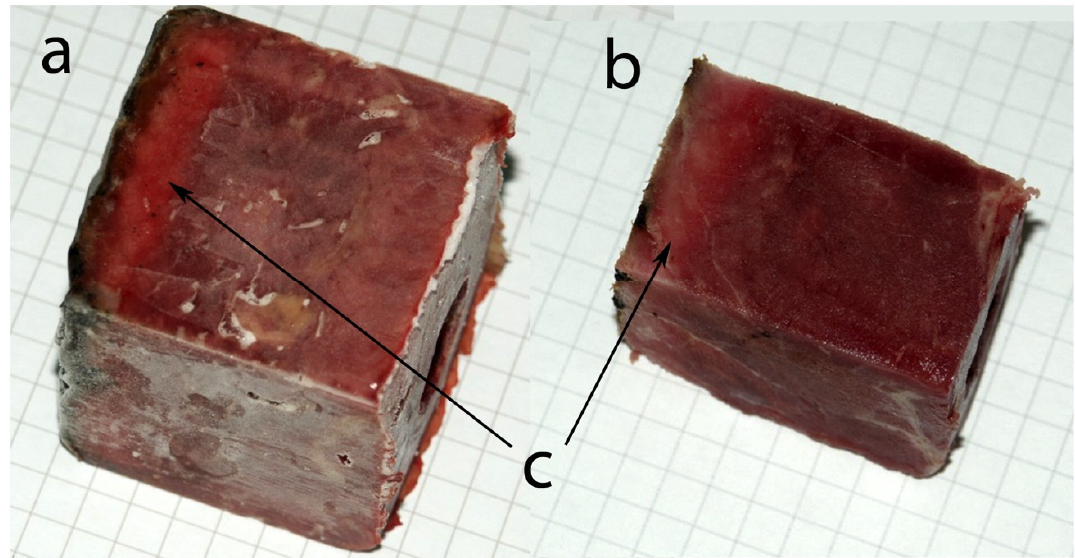
Figure 3. A frozen muscle fragment after the experiment with CO; pattern 4 with the superficially charred surface. ( a ) After removal from the chamber; ( b ) after cutting off 5 mm peripheral layers and superficial charring; ( c ) brighter, vividly red diffusion area.